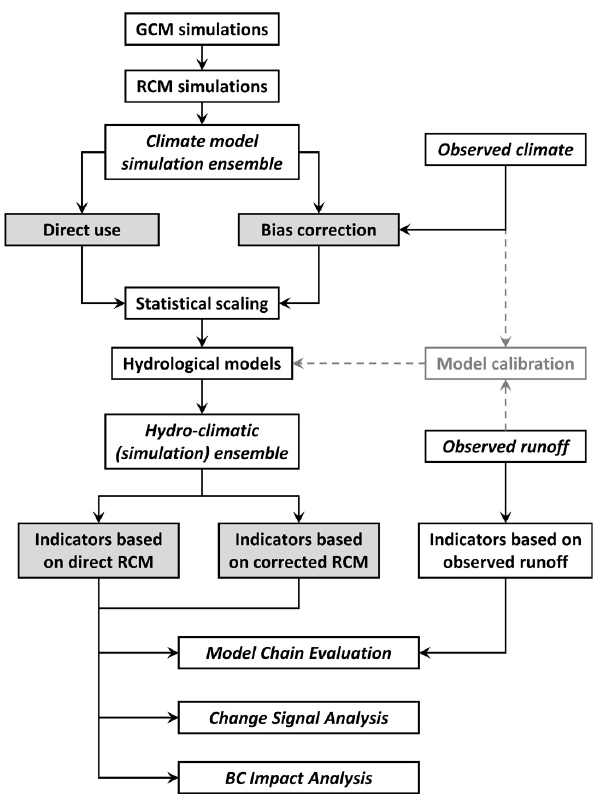
Fig. 2. Workflow of the hydro-climatic ensemble scheme used to in- vestigate the impact of bias correction on simulated runoff regimes. Dashed arrows illustrate the model calibration done in advance of the impact